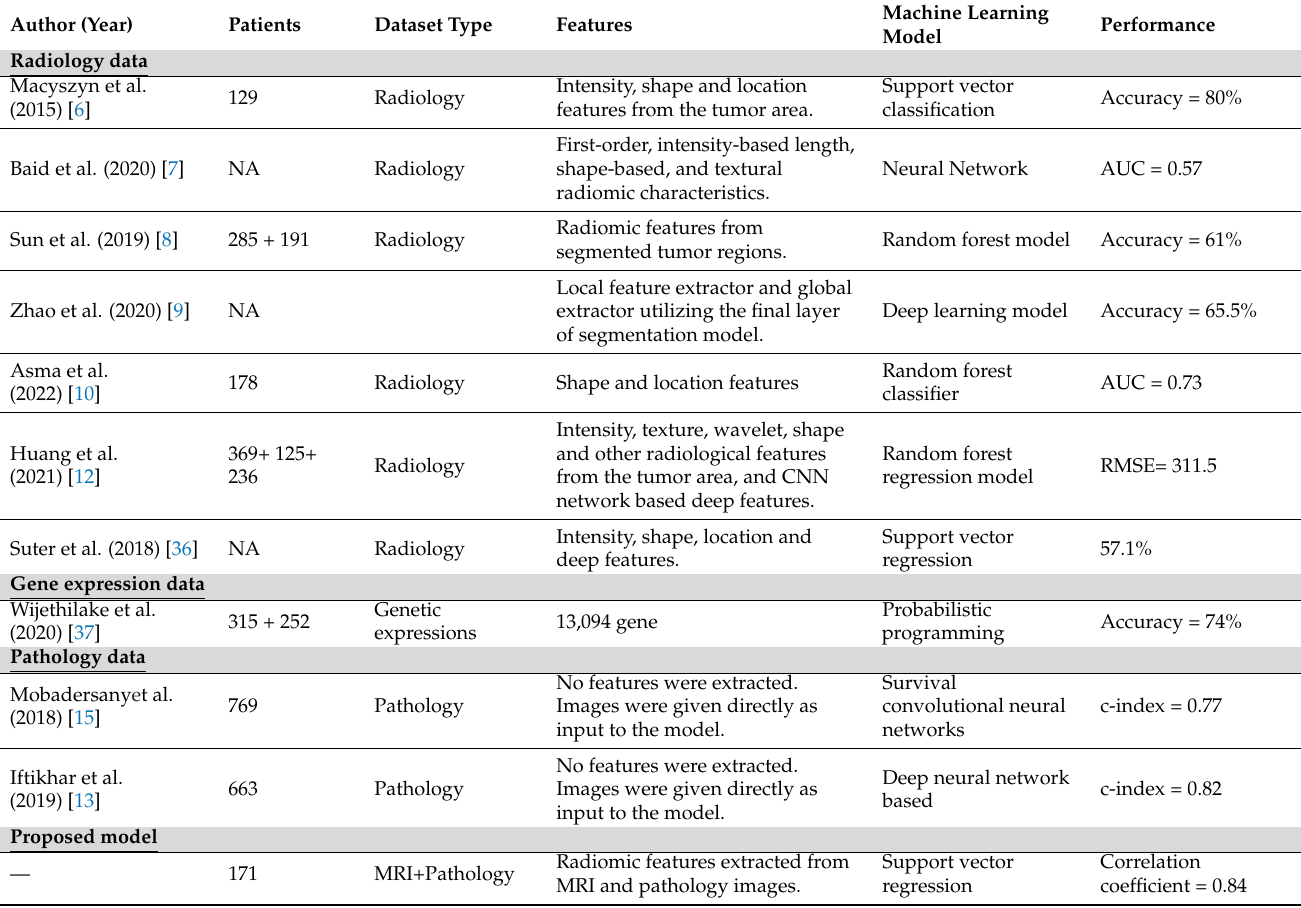
Table 3. Comparison of the proposed method with existing survival prediction